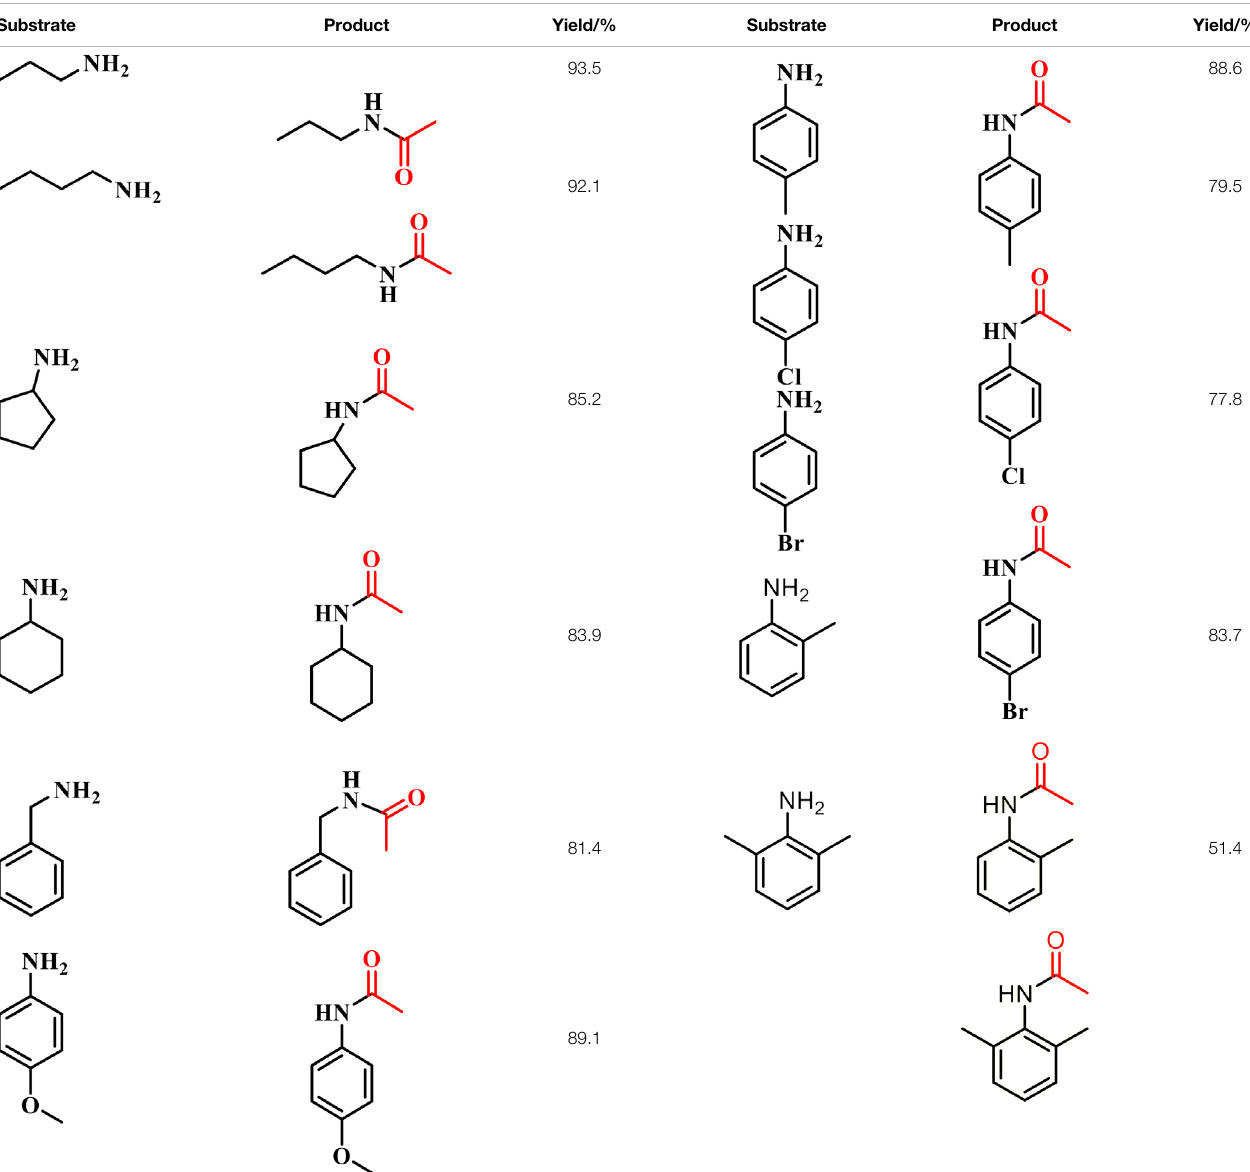
TABLE 1 | Substrate scope in terms of amines. Substrate